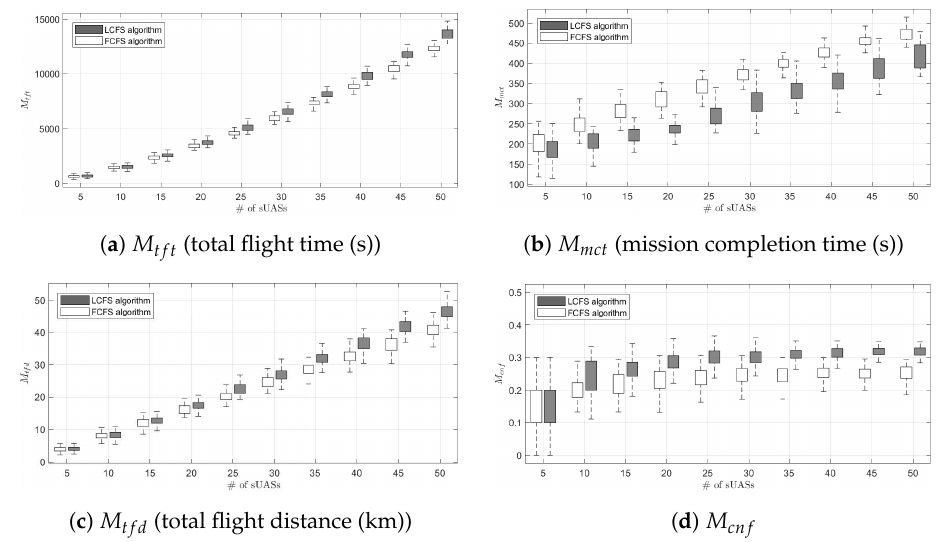
Figure 12. N -to- M Case: Standard deviation comparisons between the FCFS algorithm and the LCFS algorithm for M tft , M mct , M tfd , and M cnf